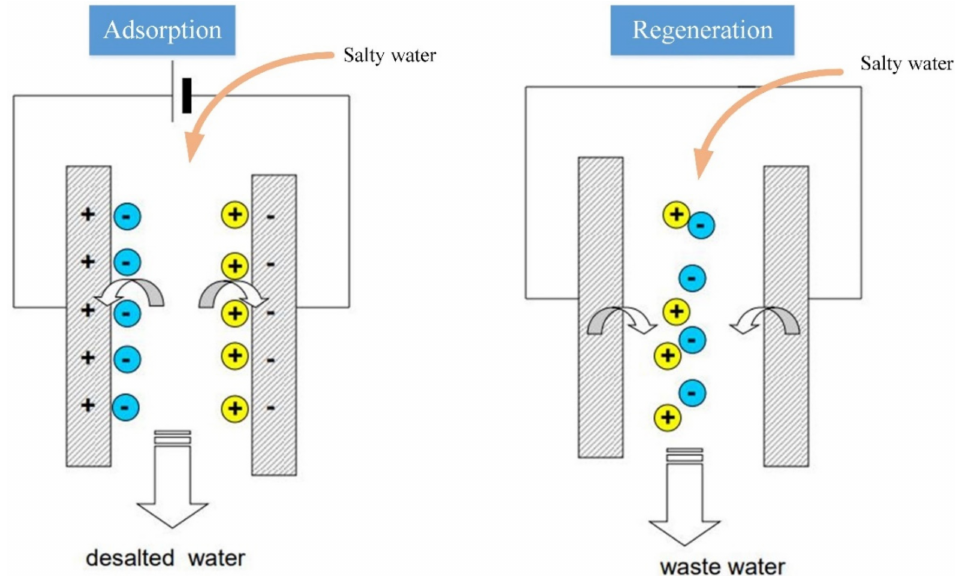
Figure 1. Two modes in the operation of CDI desalination.